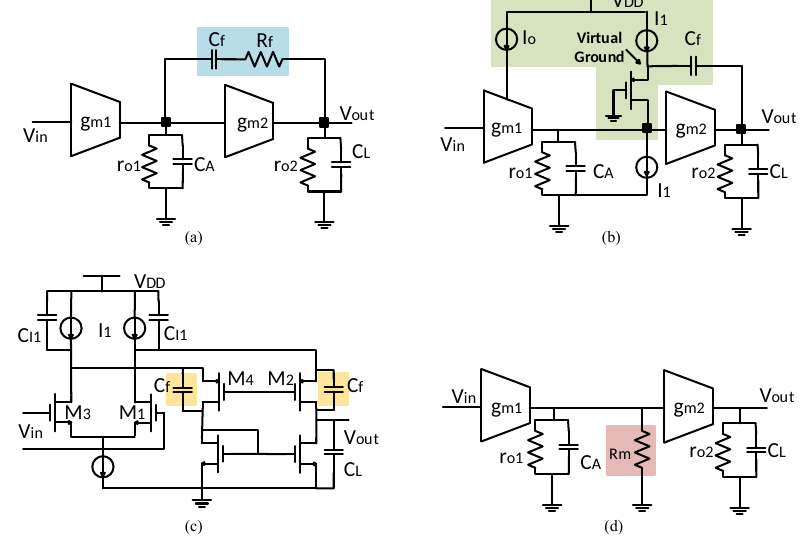
Figure 1. ( a ) Conventional Miller frequency compensation [25]. ( b ) Ahuja frequency compensation [26]. ( c ) Conventional feedforward frequency compensation [27]. ( d ) Pseudo single-stage amplifier [42]. (Diagrams were redrawn with simplification in order to facilitate the comparison among different compensation